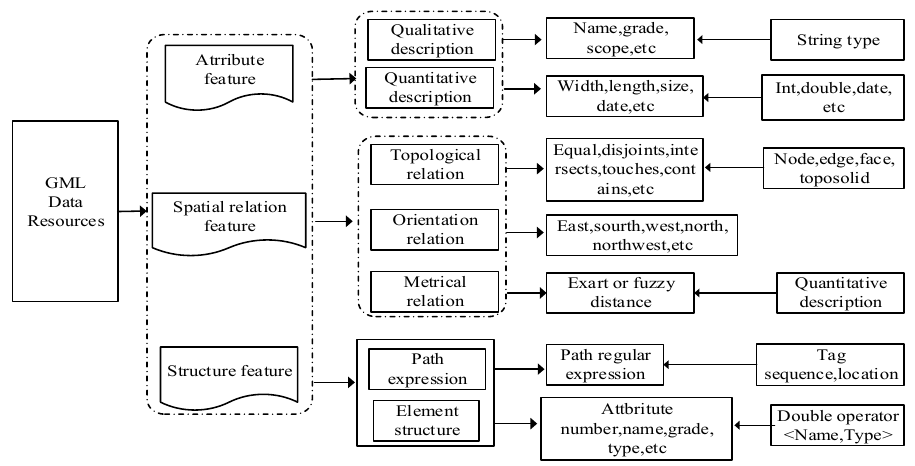
Figure 2. Model of GML data features.